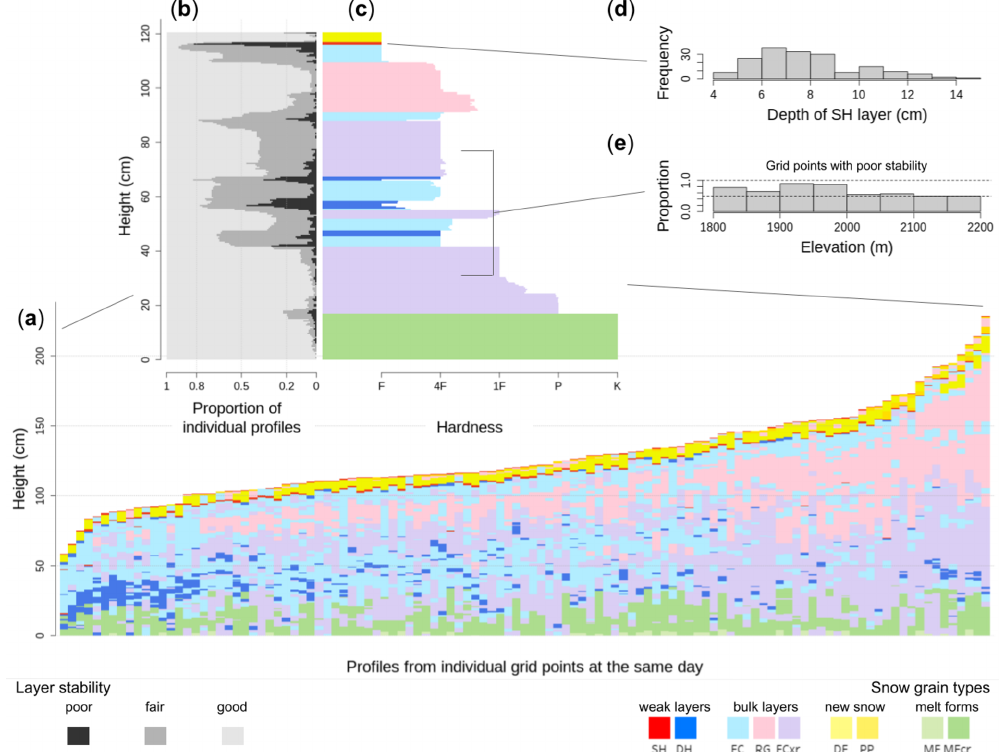
Figure 2. (a) Snow profile set from an avalanche forecast region, (c) which is summarized by the average profile. The average profile provides access to distributions of layer and profile properties, such as, for example, (b) the distribution of layer stabilities derived from threshold sums, (d) the depth distribution of a SH layer that is starting to get buried, and (e) the elevation distribution of the proportion of profiles that contain layers with poor stability in